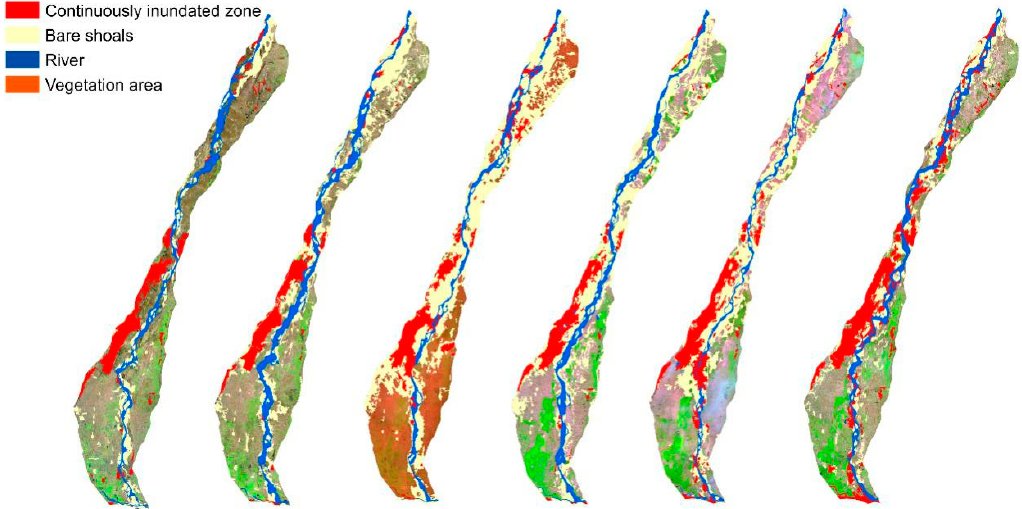
Figure 4. Wetland areas in the dry seasons of 2014–2019: the bare shoals are referred to as exposed areas in a river without vegetation, but flooded by water from time to time. The continuously inundated area was identified as the areas covered by water for most of the year. The vegetation area was the zone covered by plants, primarily by reeds.